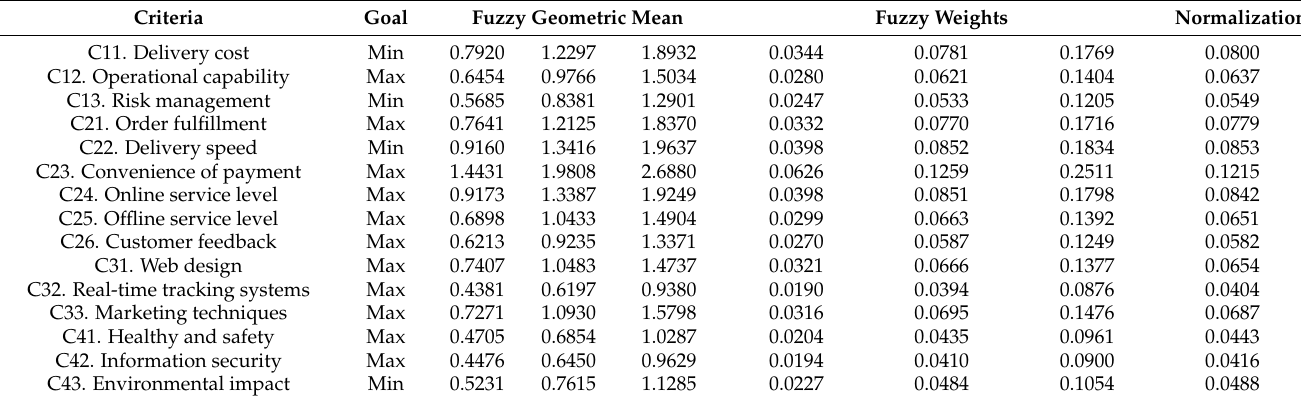
Table 8. The fuzzy weights and their normalization of each criterion of FAHP model.